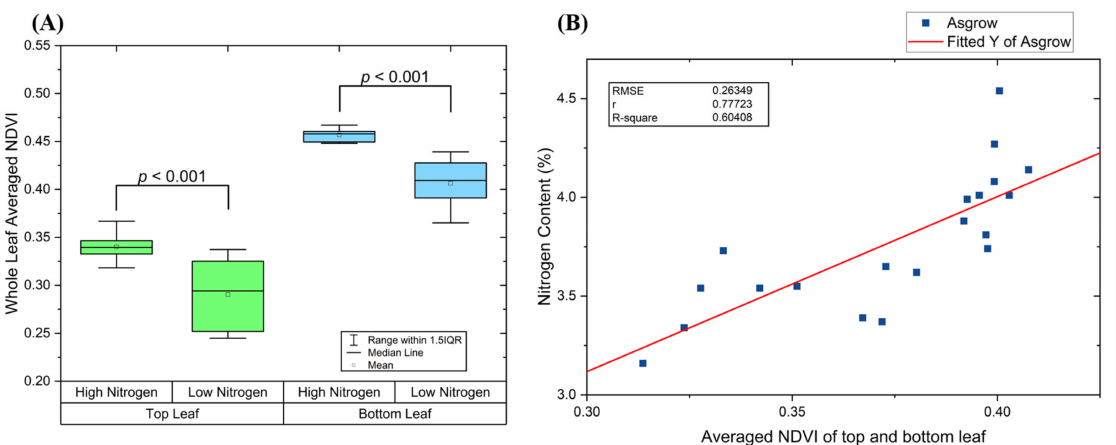
Figure 6. ( A ) Whole leaf averaged NDVI by leaf position and by nitrogen treatment. ( B ) Correlation of whole leaf averaged NDVI with the reference nitrogen